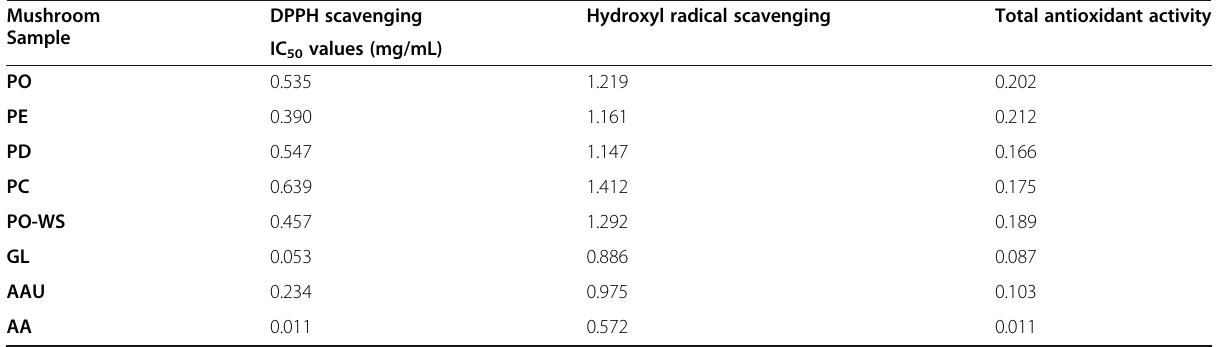
Table 5 Free radical scavenging activity of the collected mushrooms Mushroom